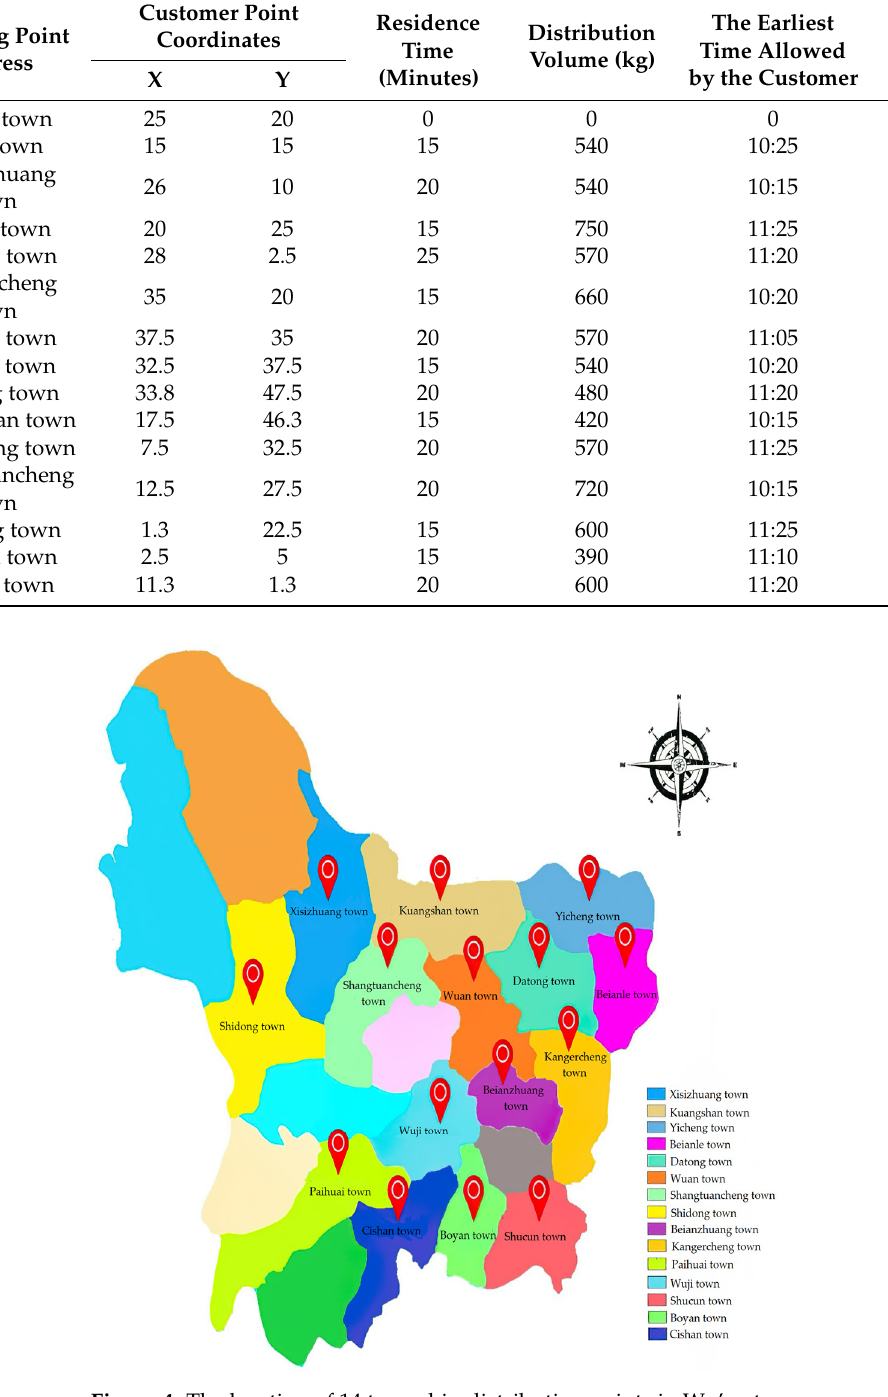
Figure 4. The location of 14 township distribution points in Wu’an town.